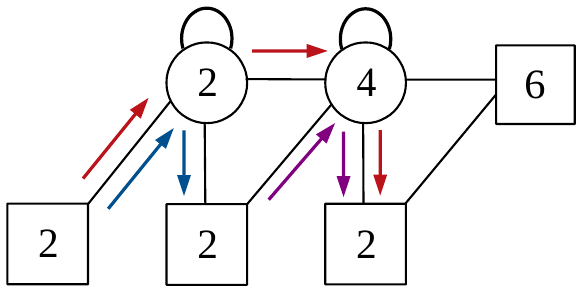
Figure 14 . SU(2) (cid:2) SU(2) bifundamental operators contributing to C in the N = 3 case.